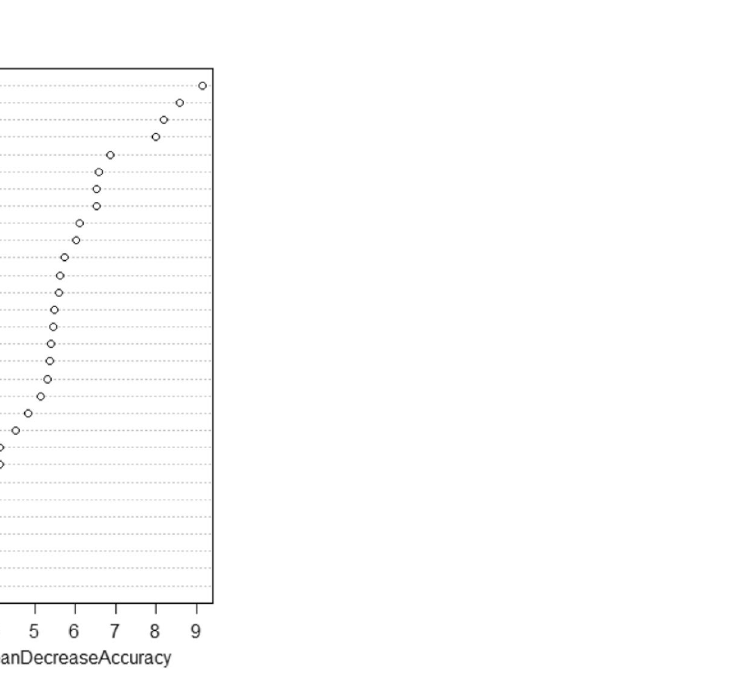
Figure 3. Variable importance plot of the second stage RF analysis in percentage of mean decrease accuracy for the factors. It shows that cefixime (Anti7), afa (Gene11), usp (Gene8), and cefazolin (Anti5) are important factors to predict recurrence after hospitalization (sample size =